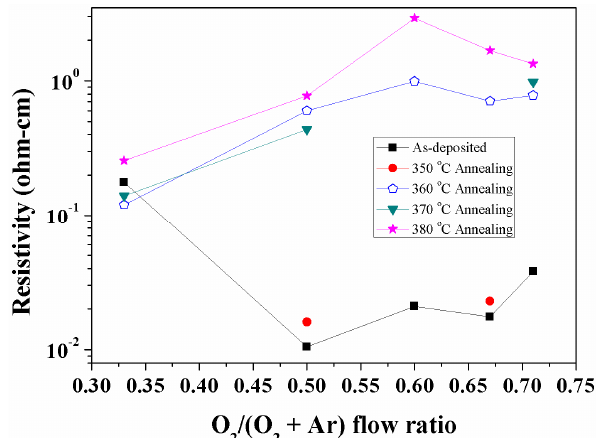
Figure 5. The variation of the electrical resistivity of SnO 2 − x thin films with various flow ratios of O 2 /(O 2 + Ar) at the annealing temperature from 350 to 380 °C and a working pressure of 4.7 × 10 − 2 Pa.